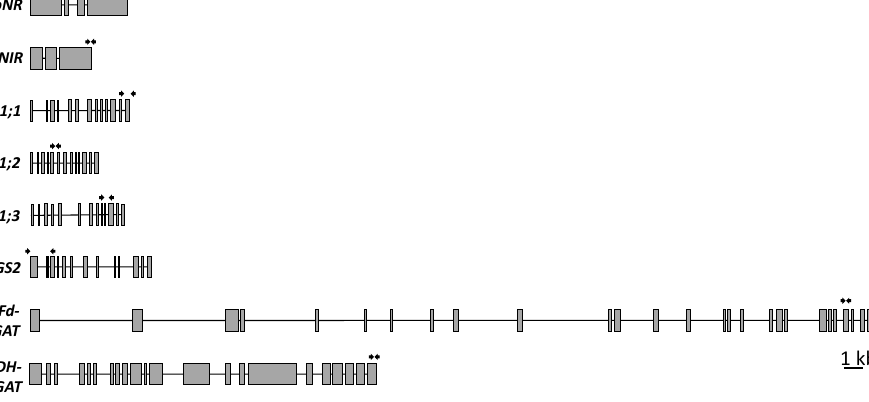
Figure 4. Structures of key S. polyrhiza genes involved in N assimilation. Exons are represented by grey boxes and lines represent introns. Arrows indicate the locations of primer binding sites used for gene expression analysis by RT-qPCR (primer sequences are listed in Table